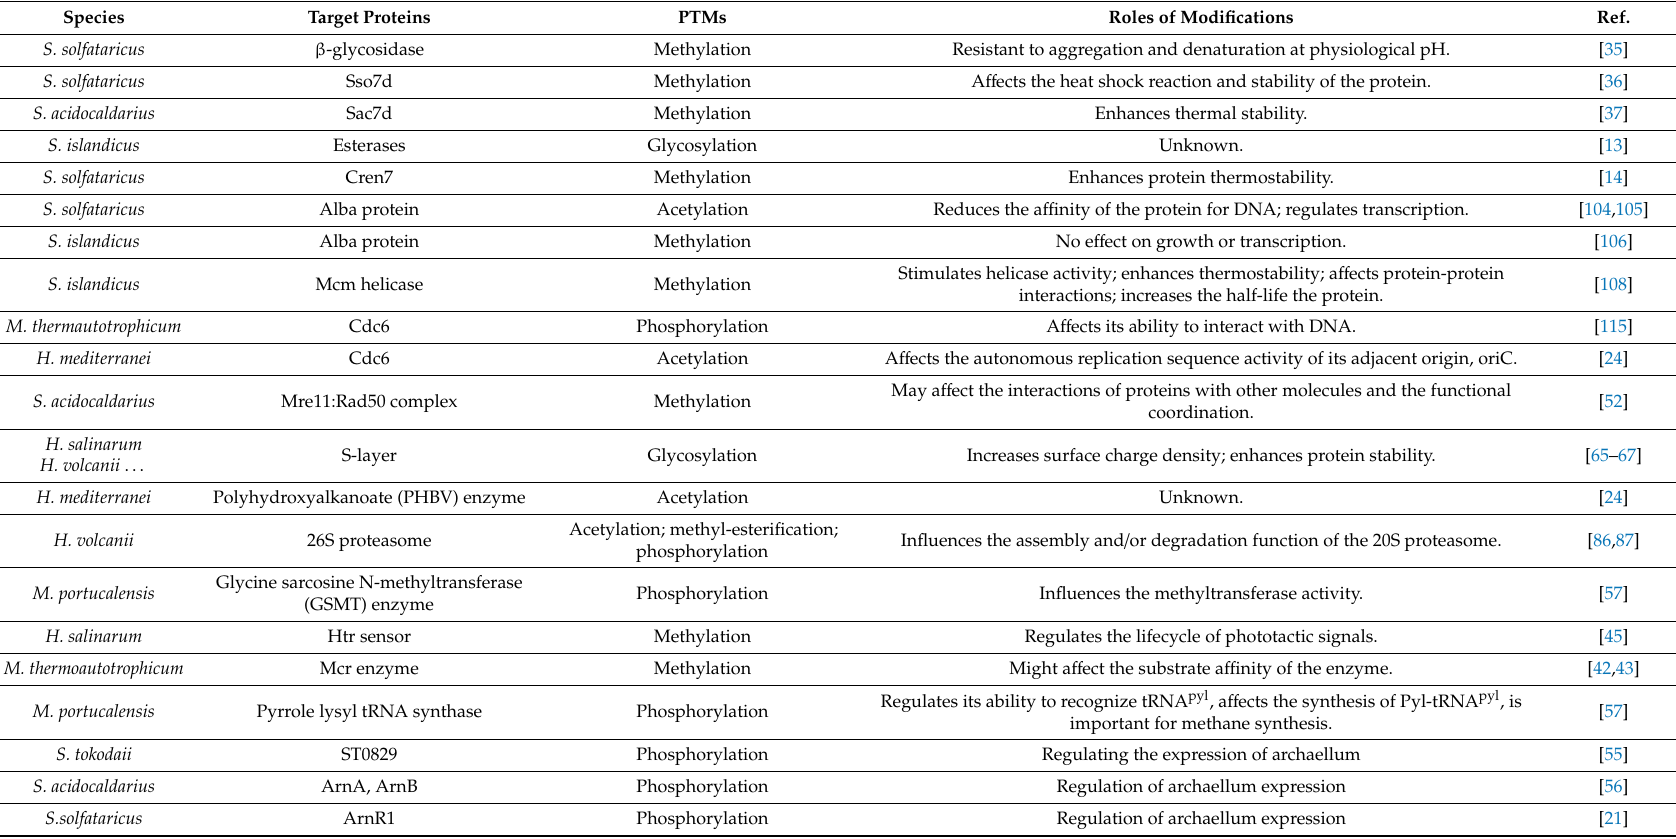
Table 2. Overview of some representative post-translational modifications (PTMs) discussed in this